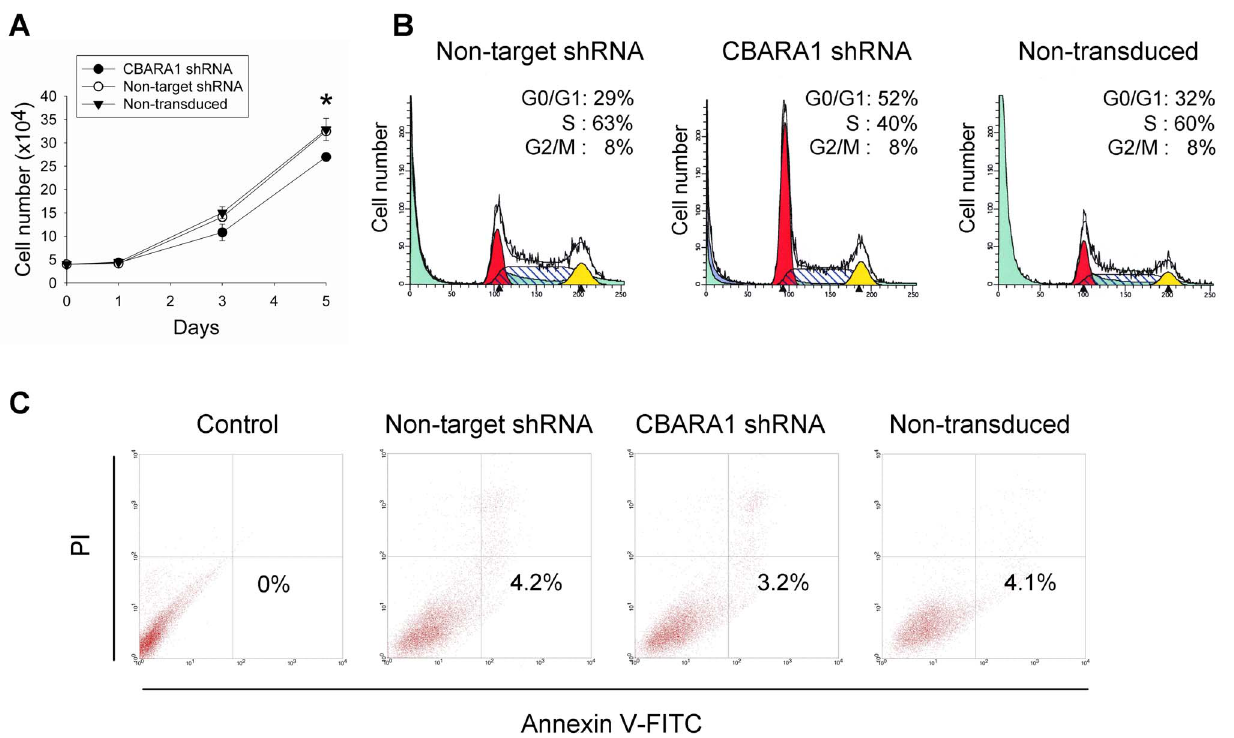
Figure 4. Effect of CBARA1 on hESC proliferation and apoptosis. (A) Graphs show a reduced cell proliferation in CBARA1 shRNA vector- transduced hES3 cells for up to 5 days after puromycin selection compared to the non-target shRNA control. Statistical analysis was performed using the Student’s t-test. *Difference compared to non-target shRNA control ( P , 0.01). (B) Cell cycle analysis shows the cell cycle distribution of non-target shRNA vector-transduced, CBARA1 shRNA vector-transduced, and non-transduced hESCs at the G0/G1, S, and G2/M phases. One graph is shown representative of two independent experiments. The percentage of cells in each phase of the cell cycle was calculated using MODFIT-LT software. (C) Annexin V/PI flow cytometry analysis showing the percentage of early apoptotic cells (Annexin V + /PI- in the lower right quadrant) in CBARA1 shRNA- treated, non-target shRNA-treated, non-transduced, and unstained control hESCs. One graph is shown that is representative of two independent experiments. Abbreviations: PI, propidium